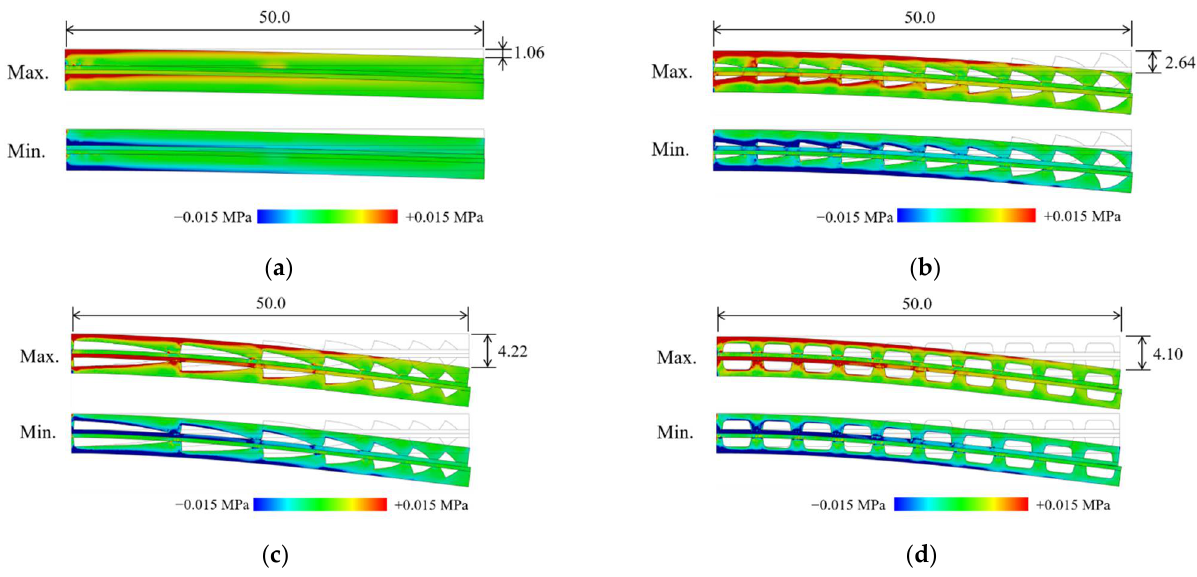
Figure 9. Maximum and minimum principal stress in a low-stiffness state in the four conditions: Homogeneous ( a ), PSL-pitch ( b ), PSL-thickness ( c ) and Pillars ( d ). The load size was 0.01 N. The size of maximum vertical deflection in each condition is shown in ( a – d ).